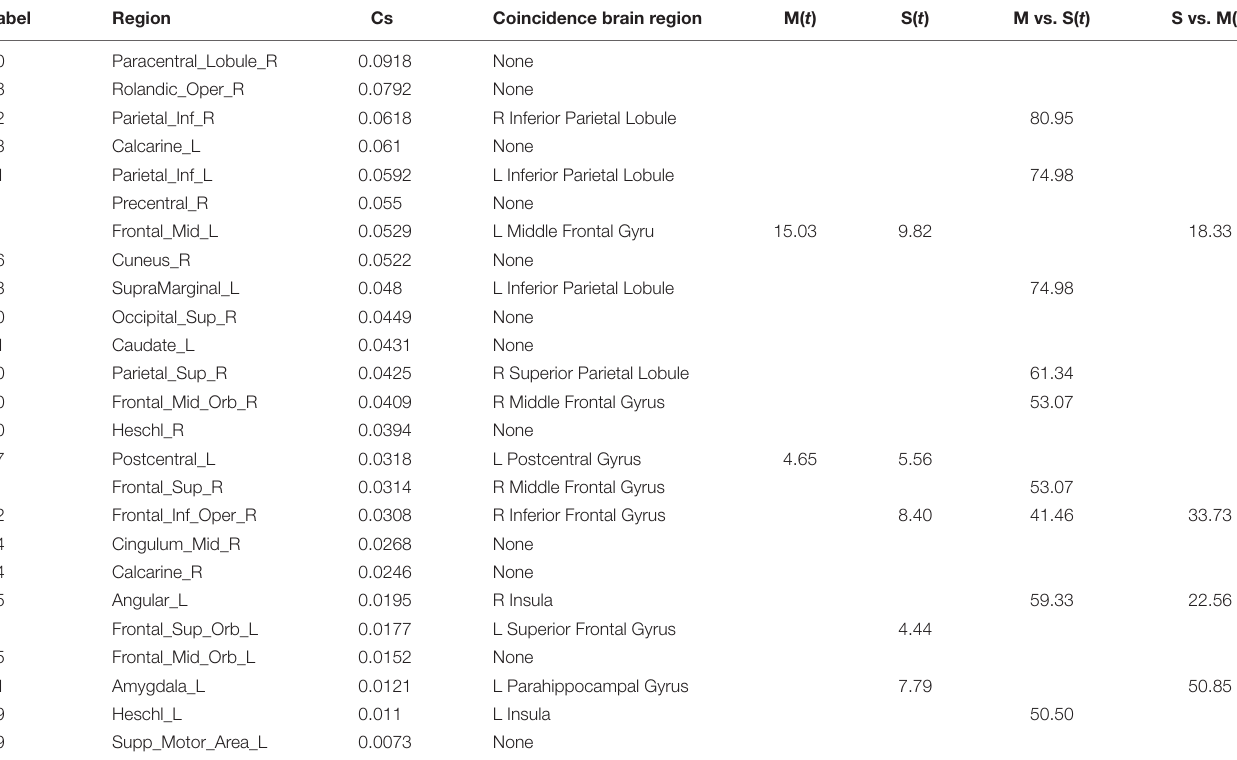
TABLE 2 | Comparison with degrees between the brain region contribution and group analysis: Label and regions represent the brain region label and brain region name of the classification result under the AAL90 template. Label Region Cs Coincidence brain